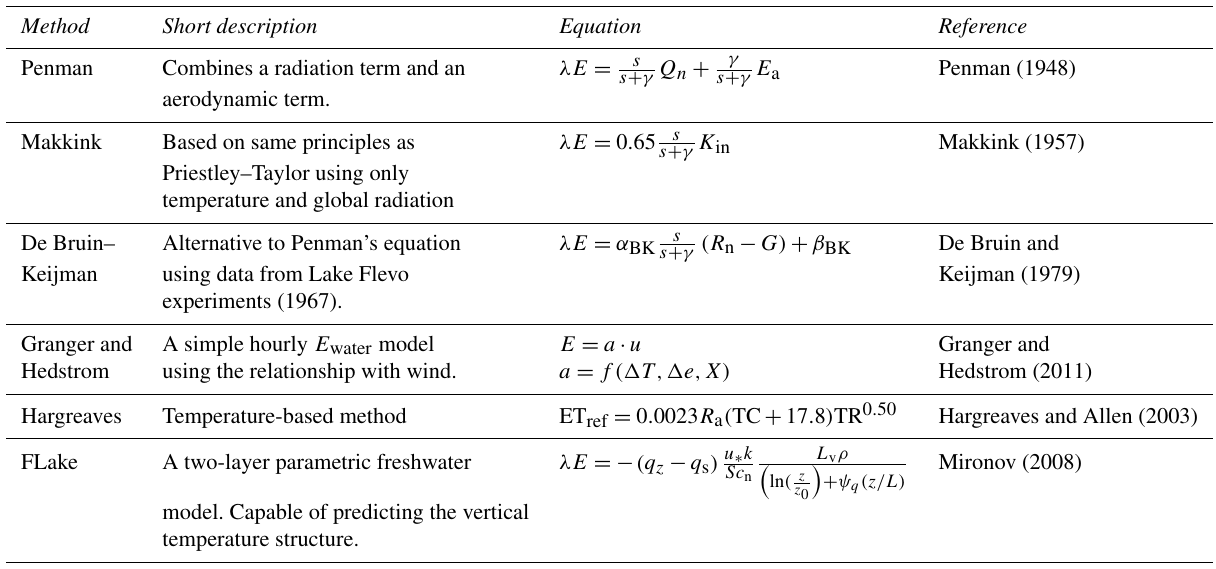
Table 1. Methods used to calculate open water evaporation. Explanations of all the variables can be found in Table A1(b).